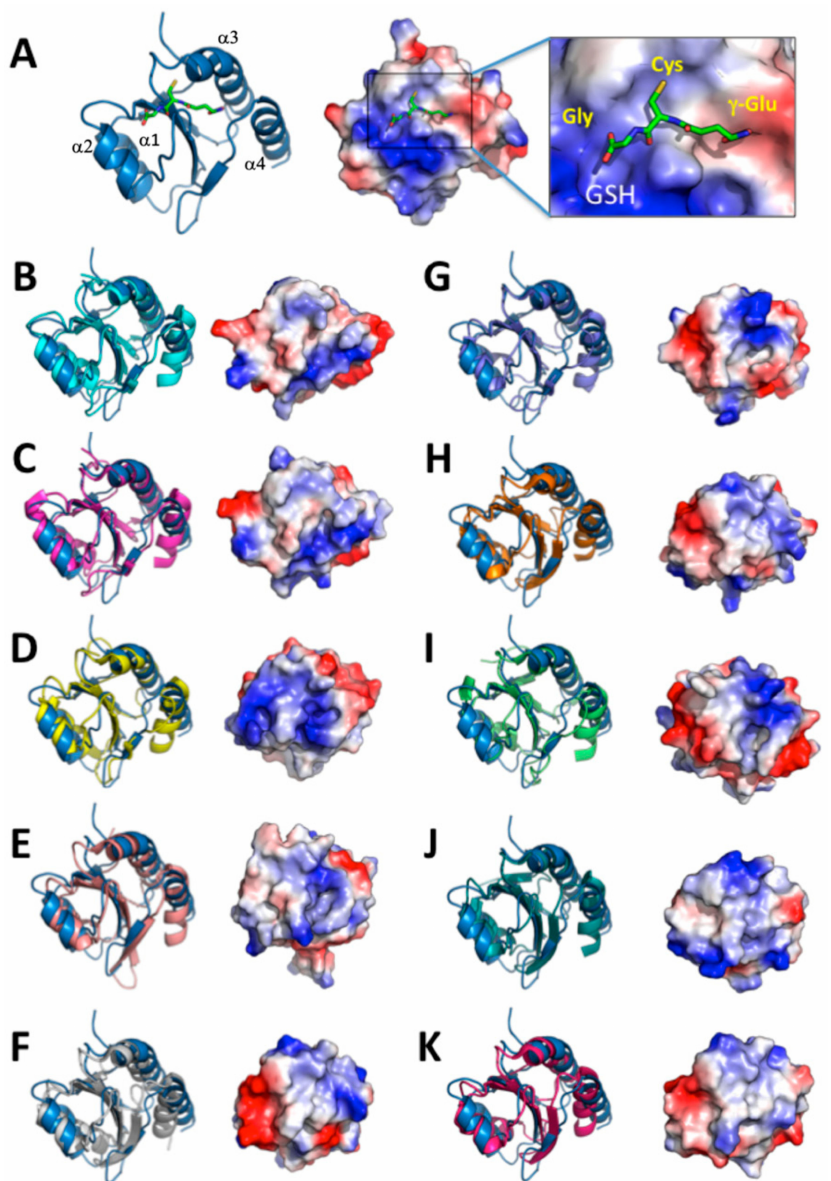
Figure 5. Comparison of structure and surface electrostatic potential of AtAPR1 redox domain with structural relatives. Electrostatic potentials (positive in blue and negative in red) of each molecule are mapped on the van der Waals surfaces. The PDB codes of the structural relatives are as follows: AtAPR1 redox domain (PDB code: 5YRY) ( A ), 3Q6O ( B ), 4P2L ( C ), 3APQ ( D ), 3APS ( E ), 1EP7 ( F ), 4EF0 ( G ), 2YOI ( H ), 2B5E ( I ), 2PPT ( J ), and 3M9J ( K